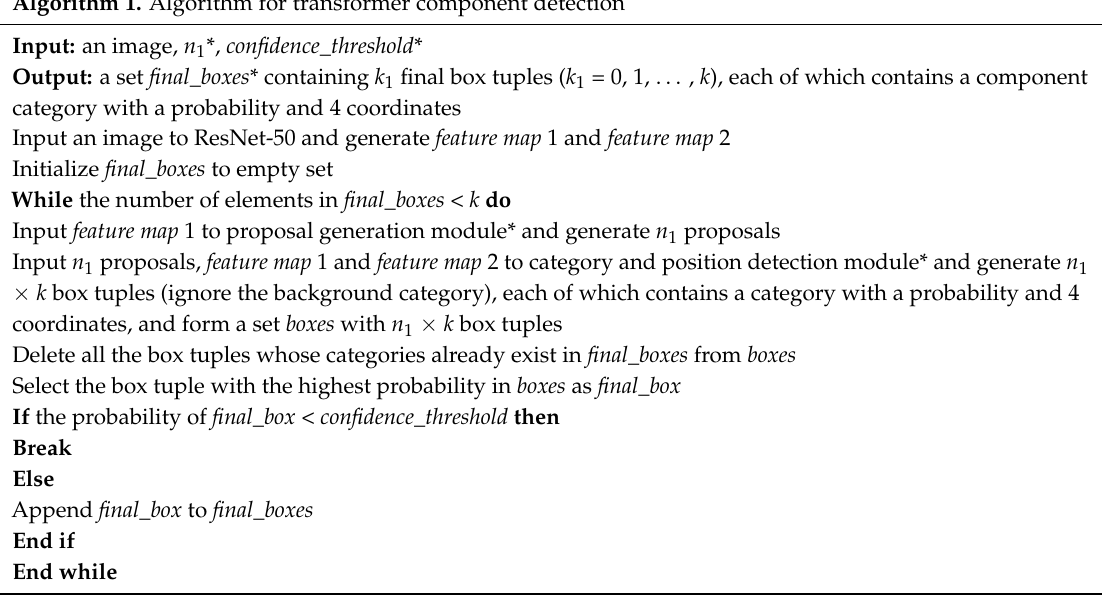
Algorithm 1. Algorithm for transformer component